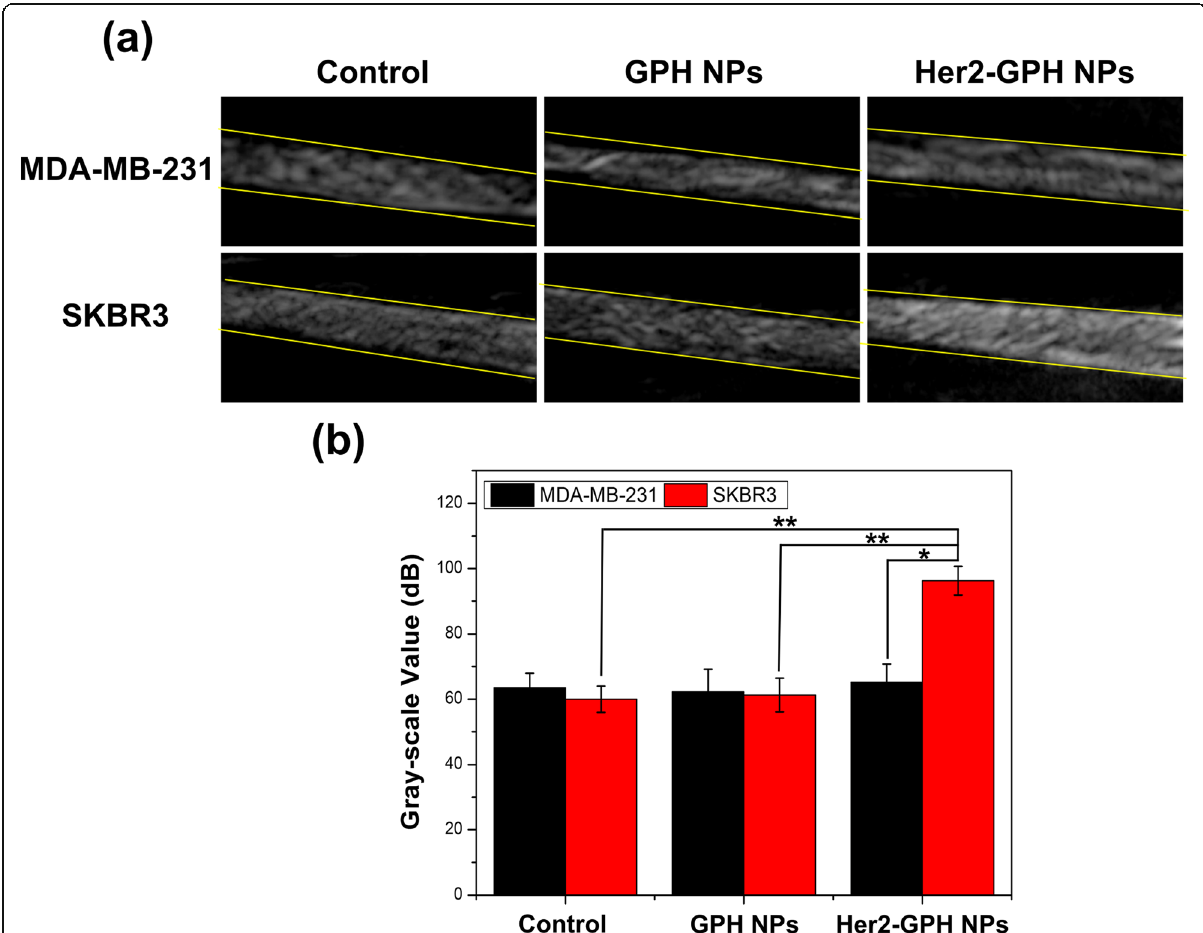
Fig. 9 a In vitro ultrasound imaging and b gray-scale value analysis of MDA-MB-231 and SKBR3 cells treated with targeted Her2-GPH NPs or non-targeted GPH NPs. MDA-MB-231 and SKBR3 cells served as controls (data expressed as mean ± SD, * P < 0.05, ** P < 0.01, n =